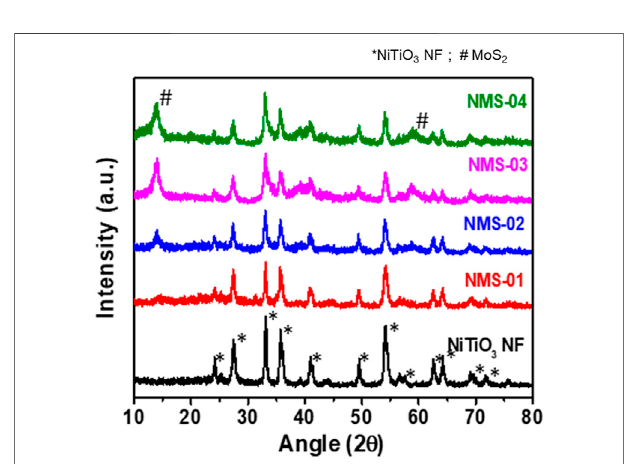
FIGURE 3 | X-ray diffraction patterns of pristine NiTiO 3 nano fi bers and NiTiO 3 /MoS 2 hybrid structures (NMS-01, NMS-02, NMS-03, and NMS-04).